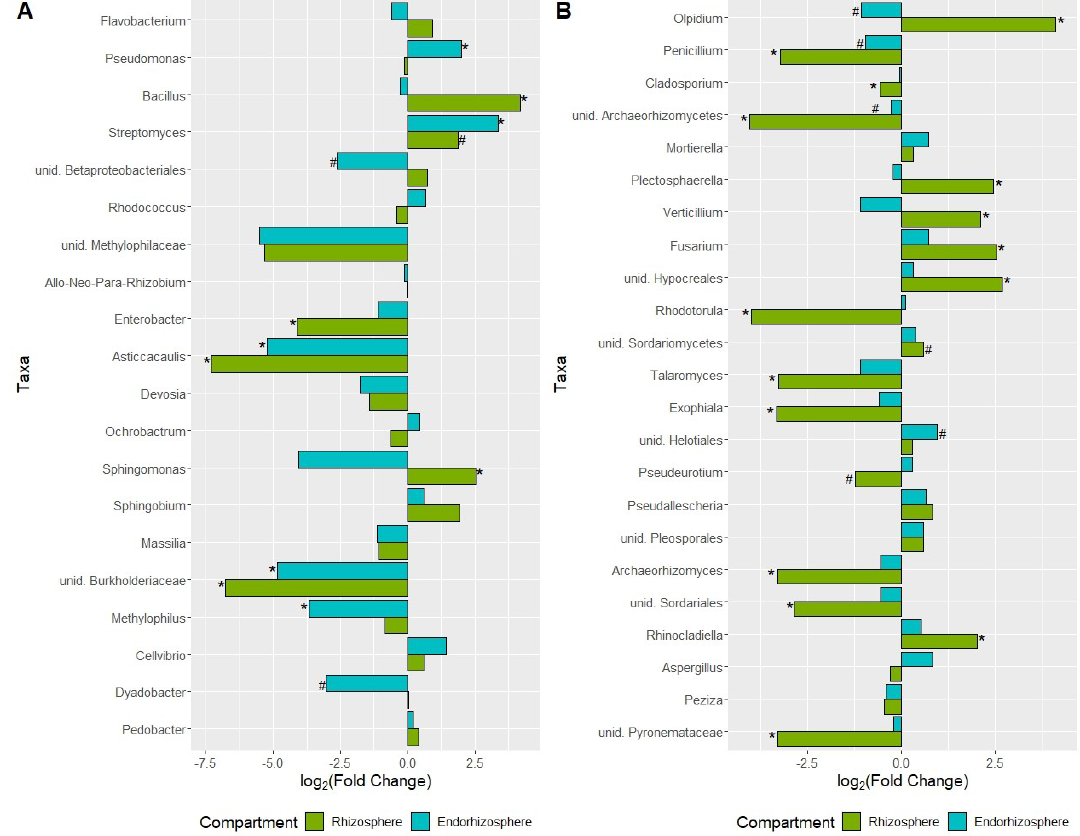
Figure 7. Differentially abundant taxa of the bacterial ( A ) and fungal ( B ) communities in the en- dorhizosphere and rhizosphere of tomatoes grown in agricultural soil versus those grown in soilless cultivation. The position along the x axis represents the fold change between the two different cul- tivations in greenhouse. All the tests were performed considering p -value (#) and the adjusted p- value with the false-discovery rate method (*, p -value FDR < 0.05).